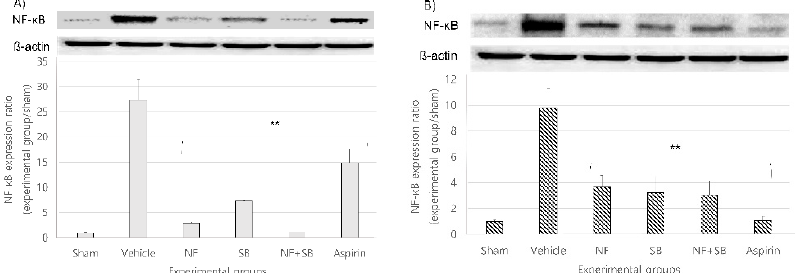
Figure 8. NF downregulates the expression of NF- κ B in the sciatic nerve at the 7th ( A ) and 14th ( B ) day following the crush nerve injury. The density data are the mean ± SEM values of experiments. (* p < 0.05, ** p < 0.01 vs. vehicle group, Kruskal–Wallis test followed by a post hoc Mann–Whitney U test).